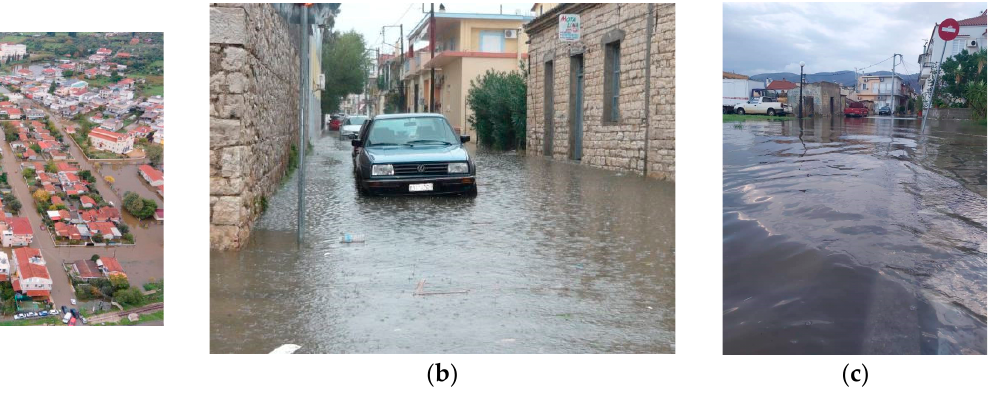
Figure 7. ( a ) Flooded Messolonghi—extreme events of 3 December 2021 [76] ( b ) Flooded Aitolikon— extreme events of 4 August 2015 [77] ( c ) Flooded Aitolikon—extreme events of 26 September 2020